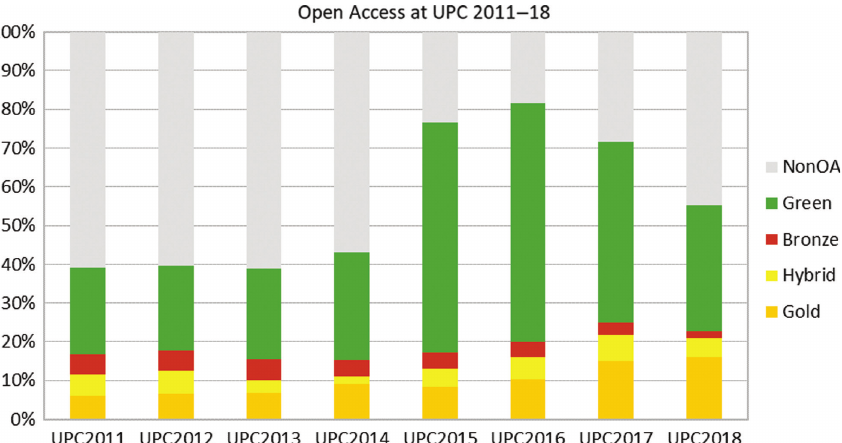
Fig. 4: Open Access situation at UPC 2011–2018. Analysis of the research publications from 2011 to 2018. Results obtained in March